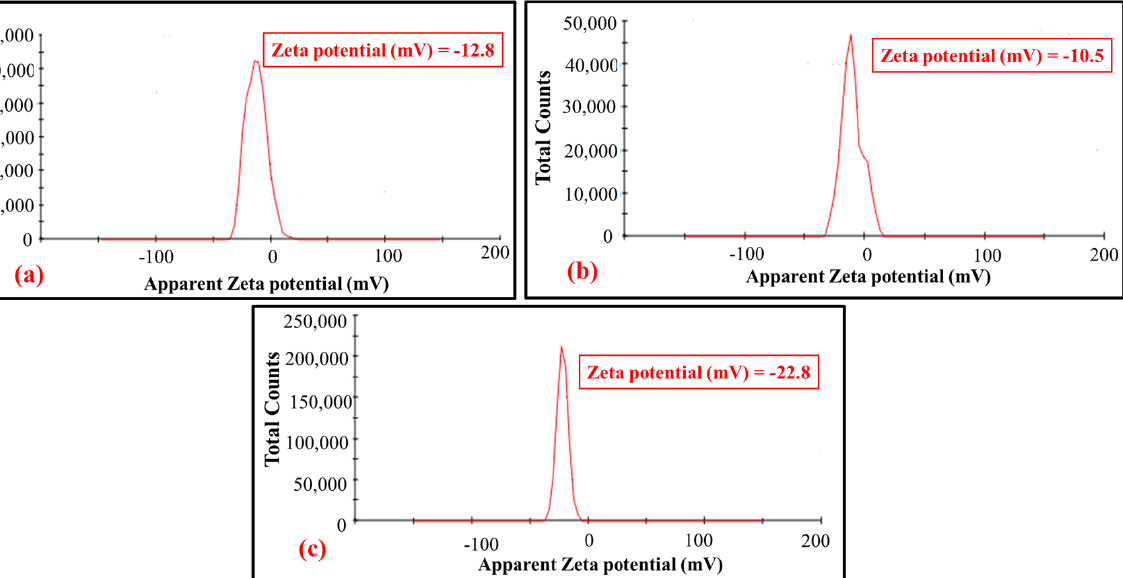
Table 3. Central composite design with variable values and percent degradation of imidacloprid.